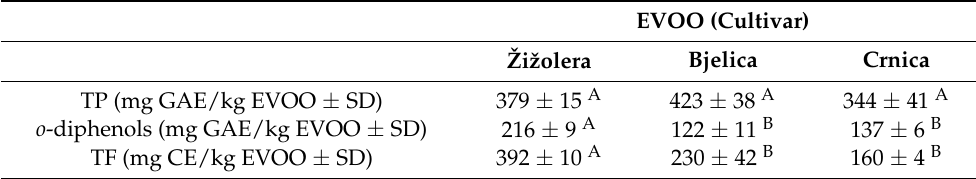
Table 1. Total polyphenols, o -diphenols, and flavonoids in EVOOs.